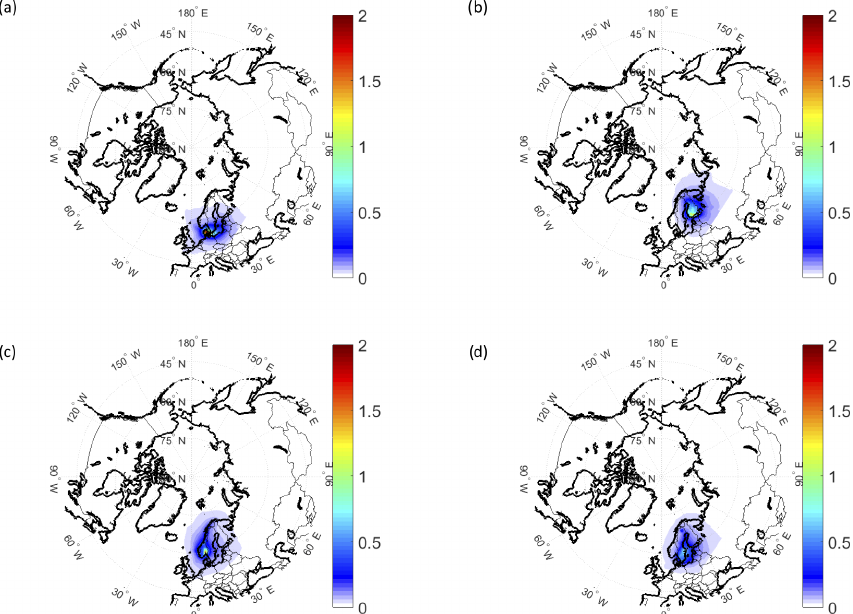
Figure 12. Spatial distributions of annual population-weighted mean absolute contributions (µgm − 3 ) of total emissions from (a) Denmark, (b) Finland, (c) Norway and (d) Sweden to surface PM 2 . 5 levels over the Nordic and the Arctic regions (north of 67 ◦